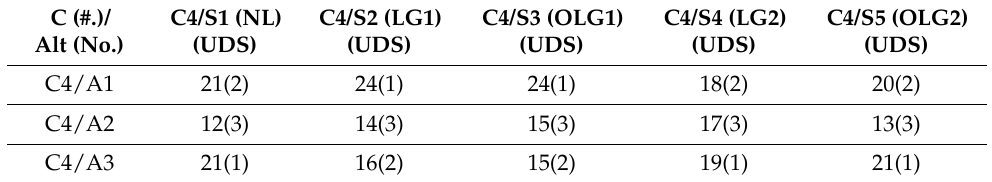
Table 20. MCDM evaluations analysis in Case 4 (C4/S1–S5) in terms of UDS for the 65-bus